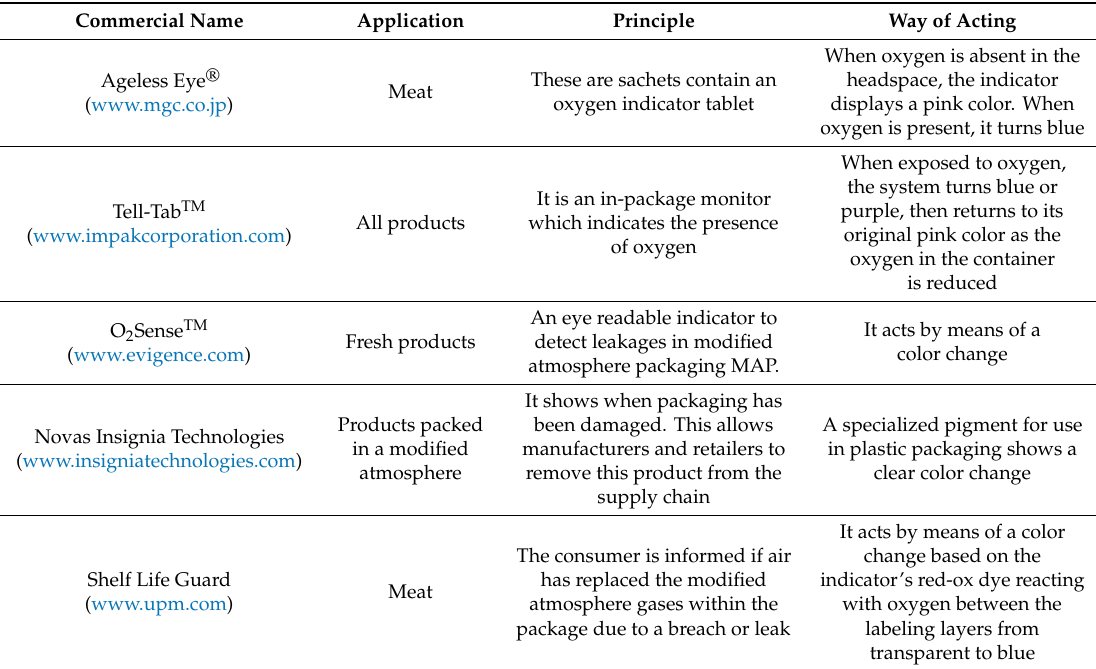
Table 6. Commercially available gas